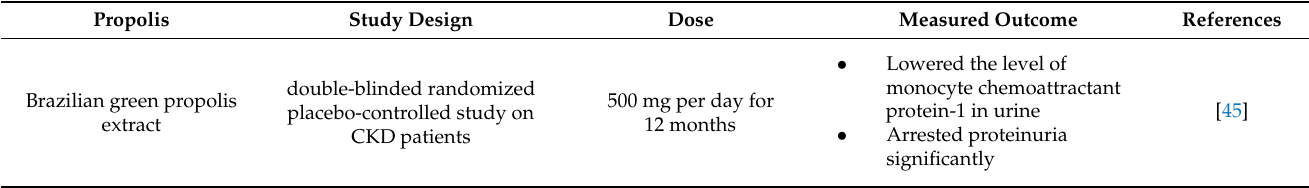
Table 4. Summary of clinical trials examining the activity of propolis and its constituents against